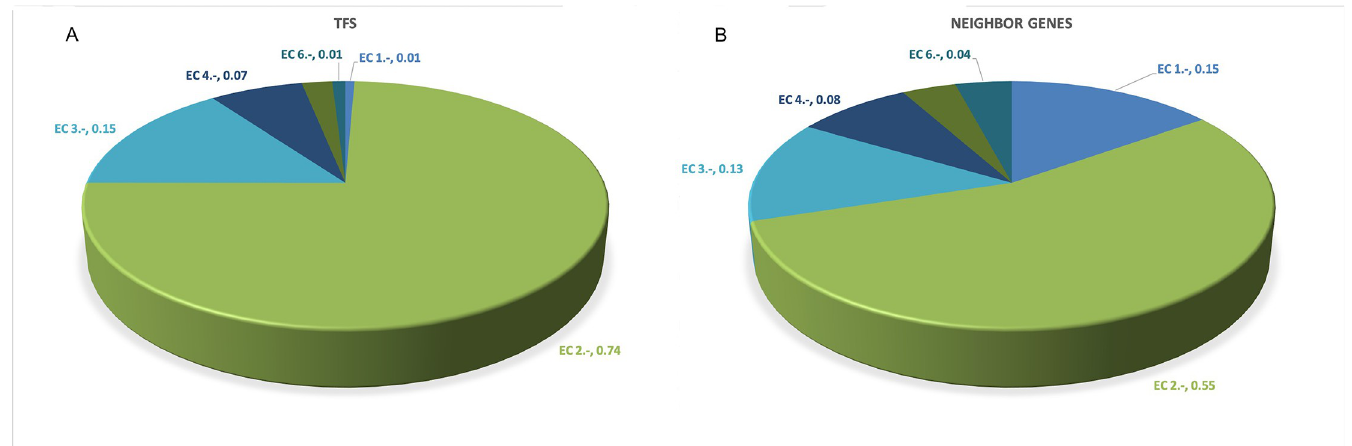
Fig 4. Enzymatic activities identified for A) TFs and for B) protein encoded by neighbor genes. The proportion of each of the six enzymatic numbers EC:1.- Oxidoreductases;. EC:2.- Transferases; EC:3.- Hydrolases; EC:4.- Lyases; EC:5.- Isomerases; EC:6.- Ligases, is indicated